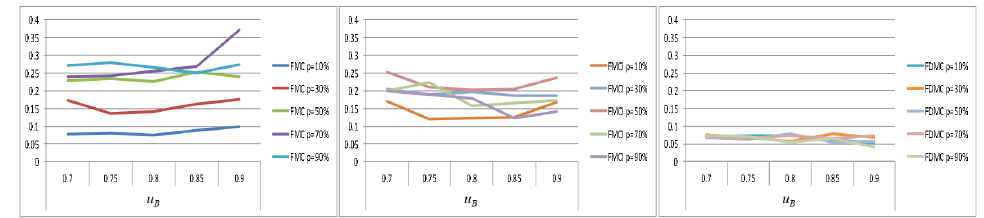
Figure 9. Evaluation of switching cost of each scheme under different p